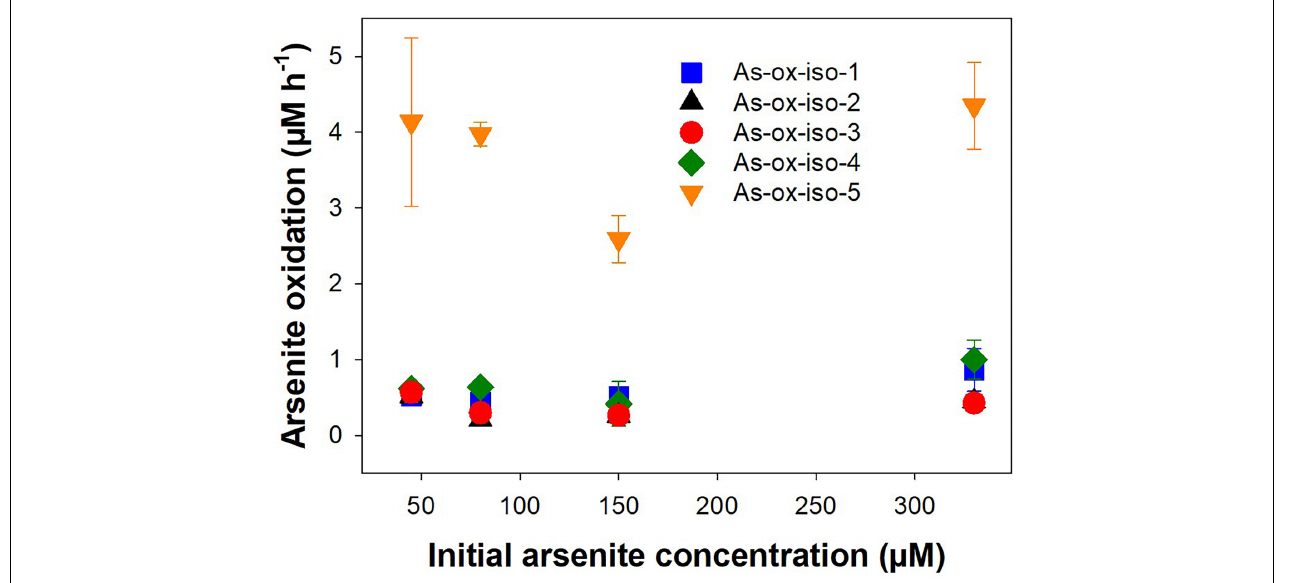
FIGURE 7 | Effect of initial arsenite concentration on arsenite oxidation rates in arsenite-oxidizing microorganisms isolated from peat soil. Strains were incubated in arsenite oxidizer medium supplemented with 45–330 mM arsenite at 20 ◦ in the dark. Rates were normalized against the OD 660 nm of the first sampling timepoint. Mean values and standard errors of three replicates are